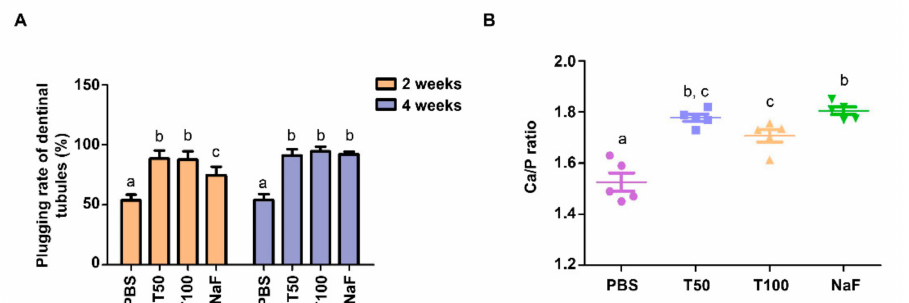
Figure 4. ( A ) The plugging rates of dentinal tubules after remineralization. ( B ) Quantitative analysis of changes in calcium (Ca) and phosphorus (P) compositions, the semi-quantitative chemical composition showing Ca/P ratio of the dentin surface after remineralization 4 weeks. Values were presented as mean with SD (n = 5), different letters indicate significant difference between groups ( p <